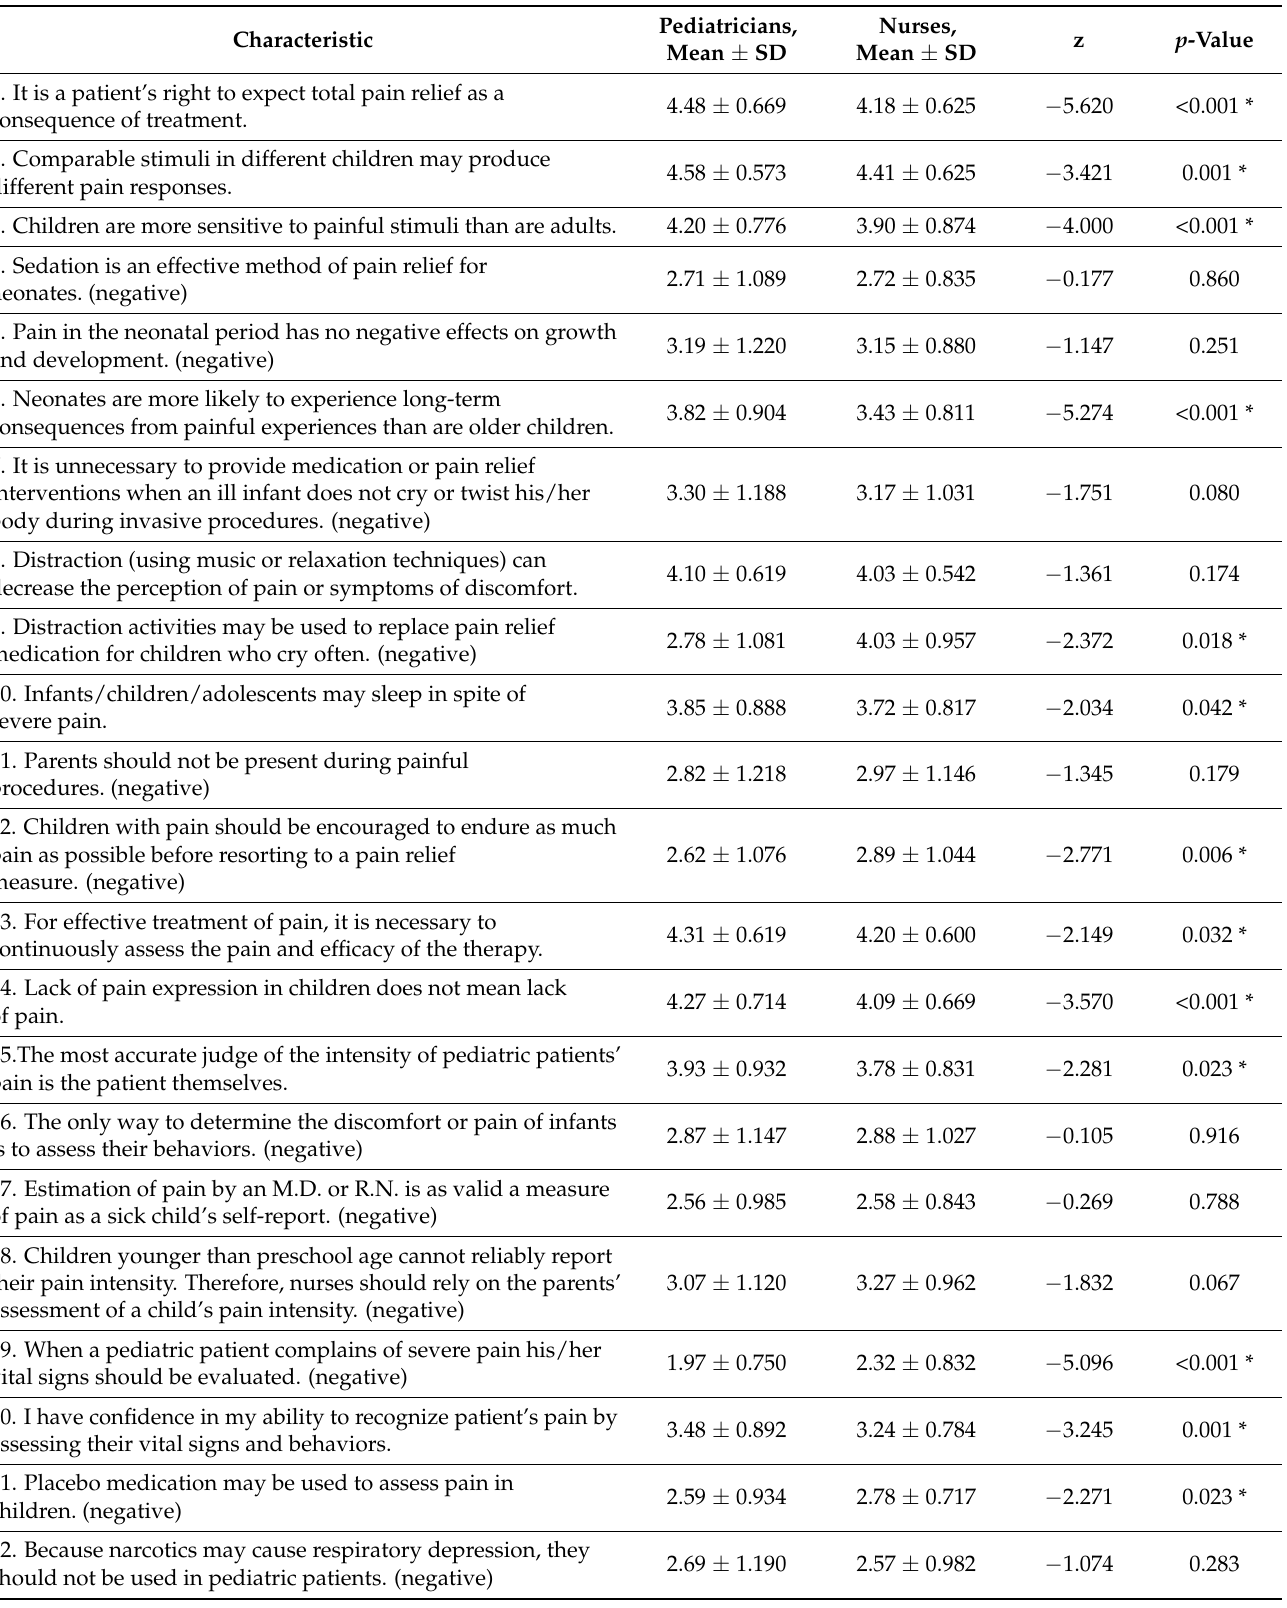
Table 2. Comparison of knowledge scores using Mann–Whitney U tests (N = 507; 214 physicians and 293